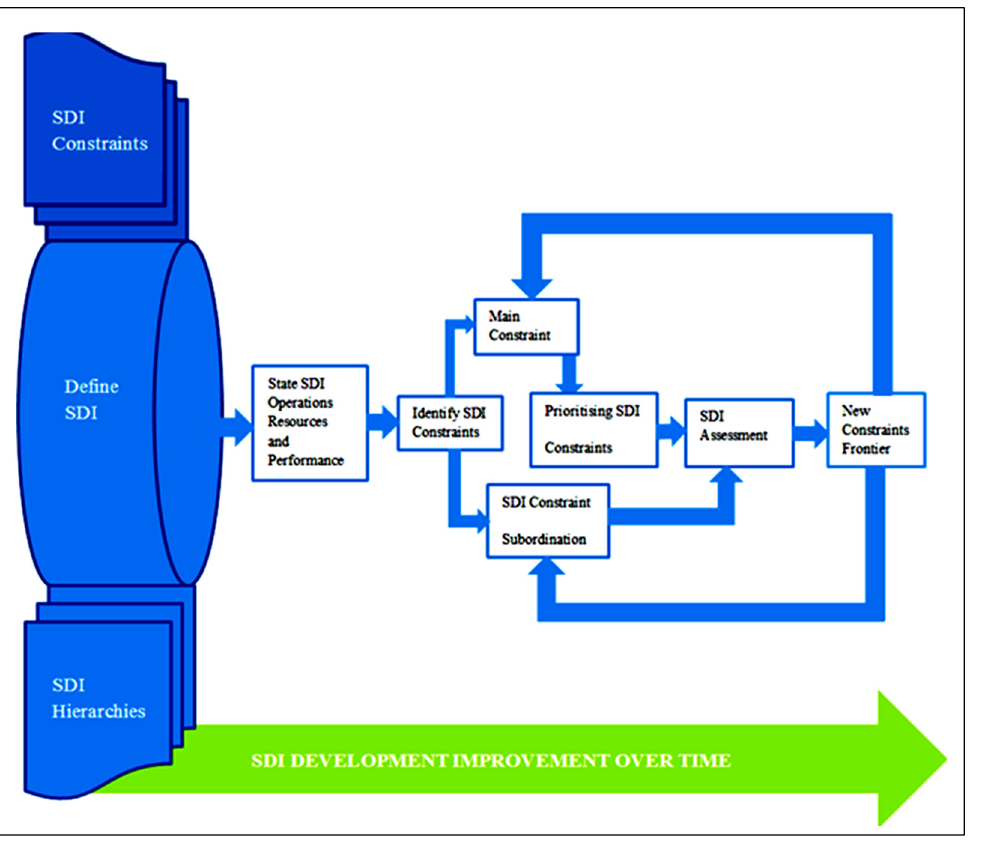
Figure 2. SDI temporal model.